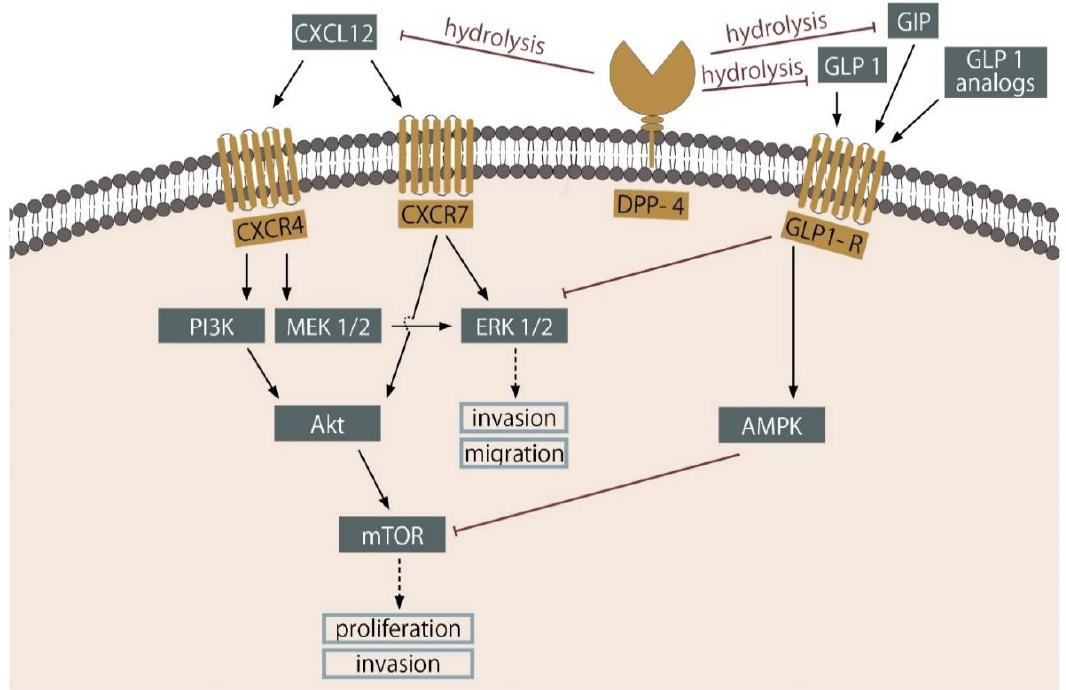
Figure 2. Mechanisms of GLP-1 and DPP-4 action on PC cells. In vivo experiments revealed that GLP-1 analogs inhibit signaling pathways engaged in tumorigenesis of PC. DPP-4 decreases the level of functional GLP-1 and GIP by its hydrolysis, and through this, attenuates binding of CXCL-12 to receptors CXCR4 and CXCR7 (detailed description in text). CXCL—ligand of chemokine receptor, PI3K—Phosphoinositide 3-kinase, Akt—protein kinase B, MEK—Mitogen-activated protein kinase kinase, ERK—extracellular signal-regulated kinases, mTOR—mechanistic target of rapamycin, AMPK—5'AMP-activated protein kinase